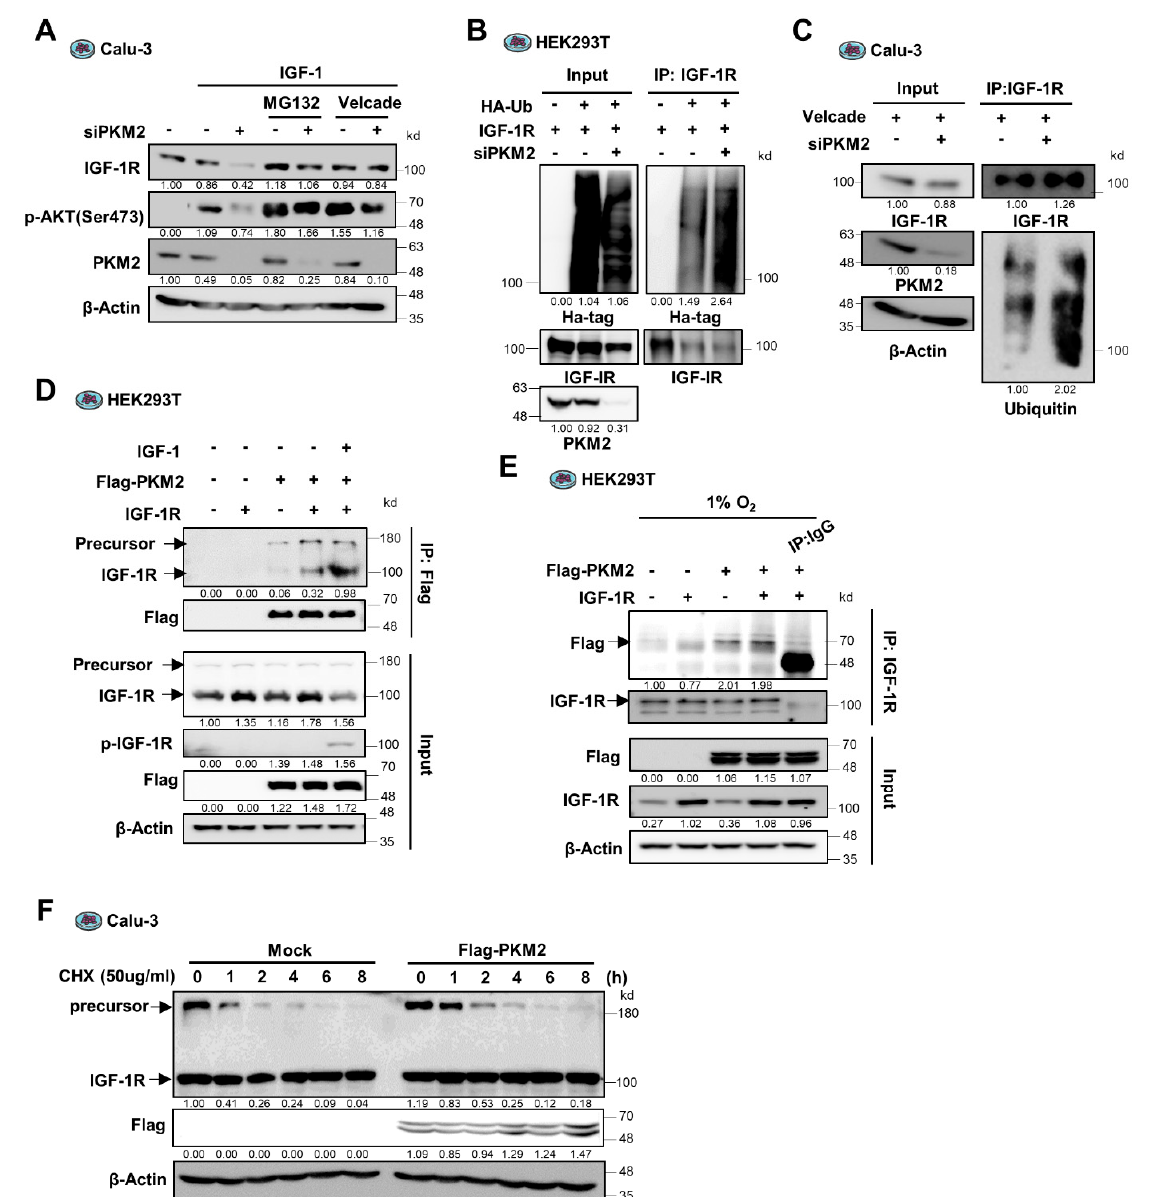
Figure 3. PKM2 physically binds to IGF-1R and regulates its stability via the ubiquitin-proteasome system. ( A ) IGF-1R and p-Ser473-AKT protein abundance in siPKM2-expressing Calu-3 cells pre-treated with the proteasome inhibitors, MG132 (10 µM) or Velcade (10 µM). IGF-1 (200 ng/mL) was treated for 12 h. ( B , C ) Ubiquitinated IGF-1R abundance in anti-IGF-1R immunoprecipitates from the extracts of siPKM2-transfected 293 T or Calu-3 cells exogenously expressing IGF-1R and HA-tagged ubiquitin, ( B ) or not ( C ). ( D ) Abundance of IGF-1R precursor and mature proteins in the anti-Flag immunoprecipitates from HEK293T cells exogenously expressing IGF-1R and Flag-PKM2. IGF-1 (200 ng/mL) was treated for 12 h. ( E ) PKM2 protein abundance in anti-IGF-1R immunoprecipitates from HEK293T cells expressing Flag-PKM2 and IGF-1R under hypoxic condition (1% O 2 ) for 24 h. Normal mouse IgG was used as the negative control. ( F ) Determination of precursor and mature IGF-1R protein stability in Flag-PKM2 expressing Calu-3 cells following CHX (50 µg/mL) treatment for the indicated time. β -Actin was used as the loading control in ( A , C – F ).